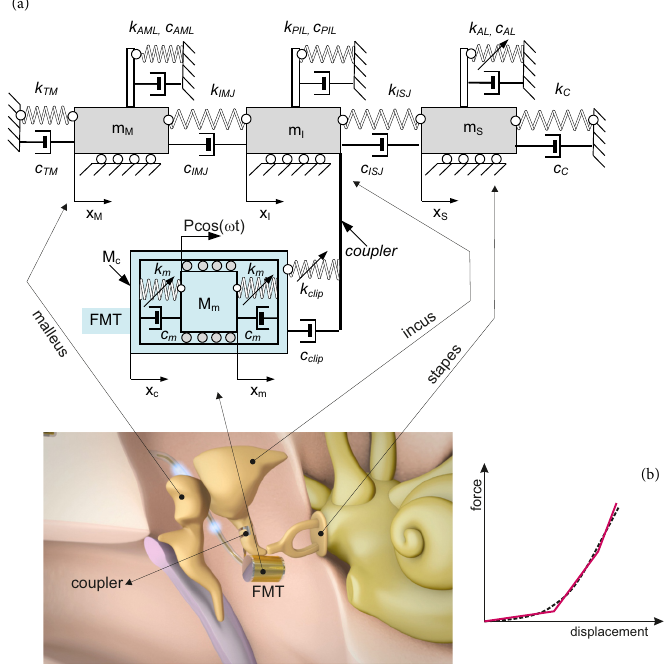
Figure 1. Five-degrees-of-freedom model of the IME ( a ), and the nonlinear characteristic of the coupler ( b